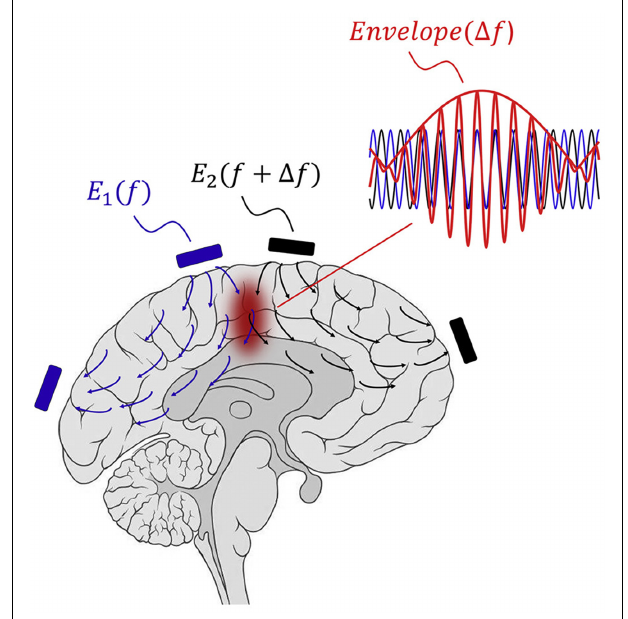
FIGURE 2 | Concept of TI stimulation. The interference of two oscillating electric fields with slightly different frequencies (f1 = 2,000 Hz; f2 = 2,010 Hz; ∆ f = 10 Hz) produces an envelope equal to ∆ f in current intersection regions (Copyright permission was obtained from the publisher; Grossman et al., 2017). TI, Temporal